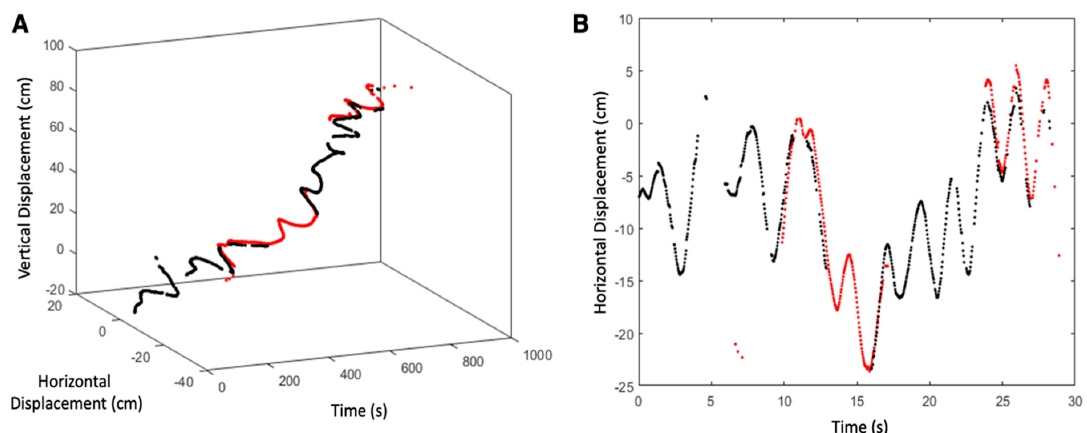
Figure 5. Representative plots tracking animal displacements over time to show horizontal displacements caused by ocean currents. ( A ) An example 2D displacement over time and ( B ) the horizontal component over time from one video (animal 1, driven at 0.50 Hz) to show oscillatory effects from primarily horizontal surface currents.